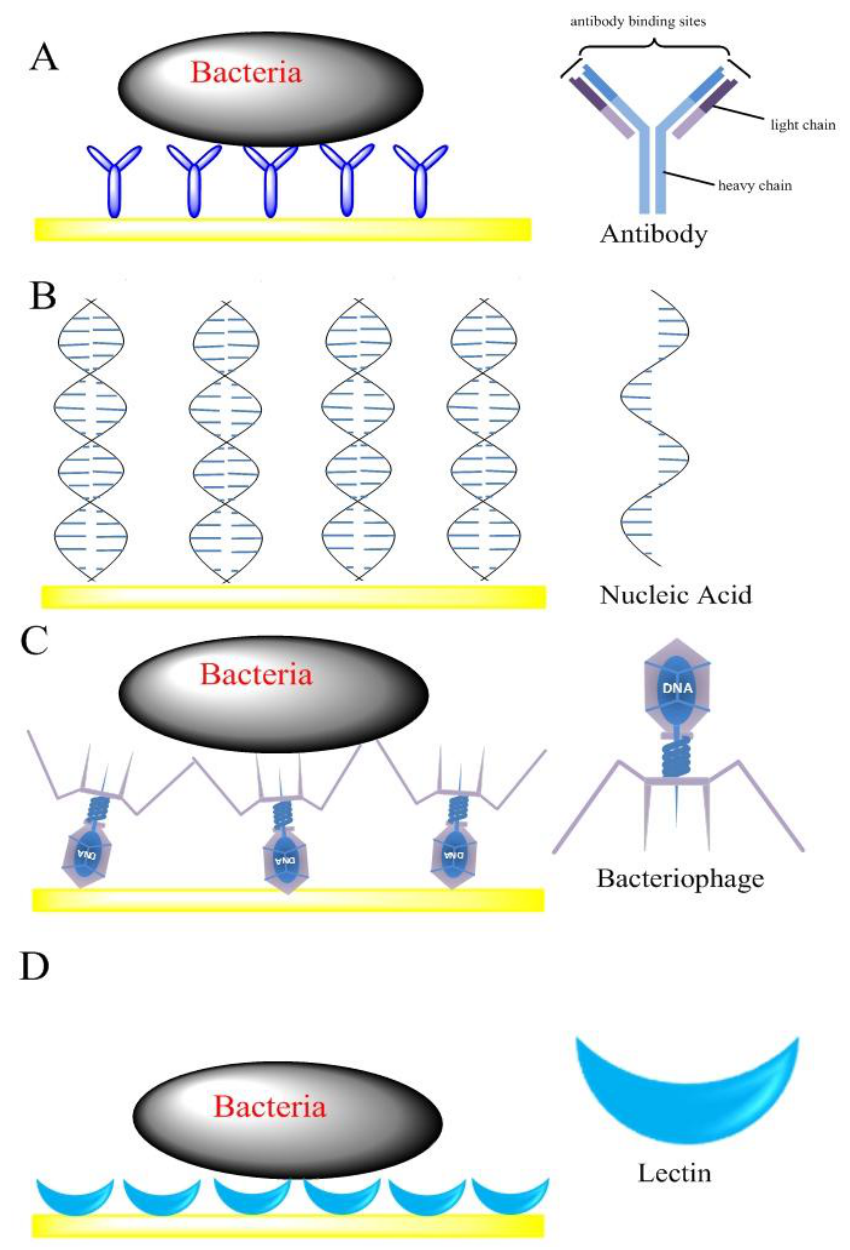
Figure 2. Schematic view of impedimetric biosensors fabricated by different ( C ) Bacteriophage-based sensor; ( D ) Lectin-based